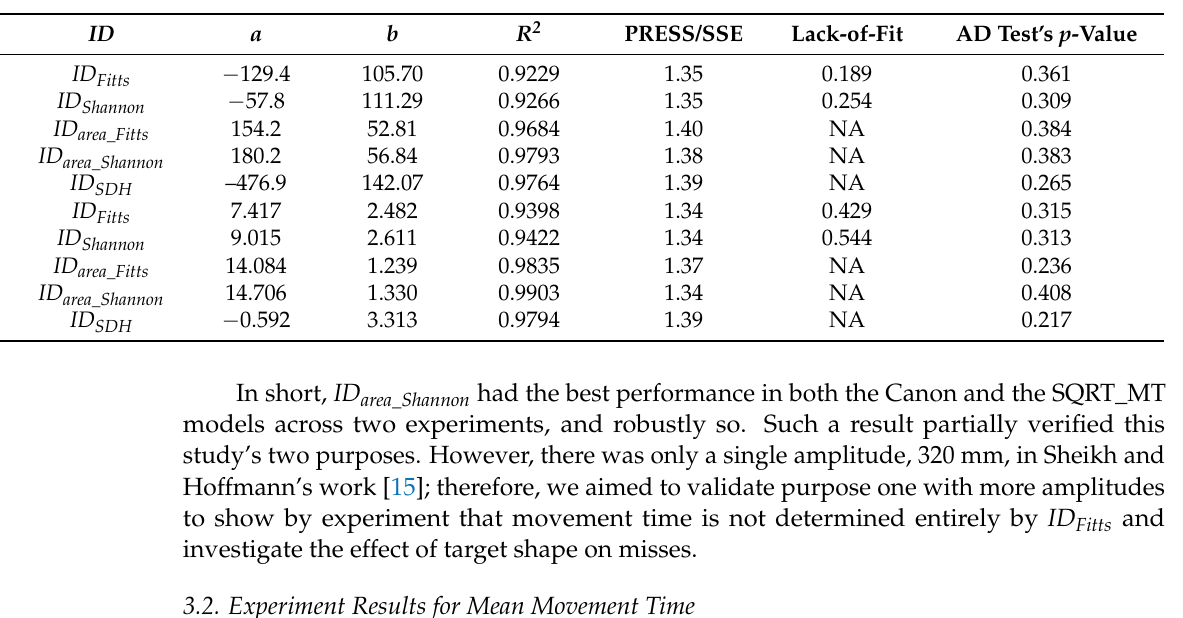
Table 2. Regression analysis of 2D target shapes data in Experiment 2 of Sheikh and Hoffmann [15]. ID area_Shannon had the best R-square in both the Cannon and the SQRT_MT